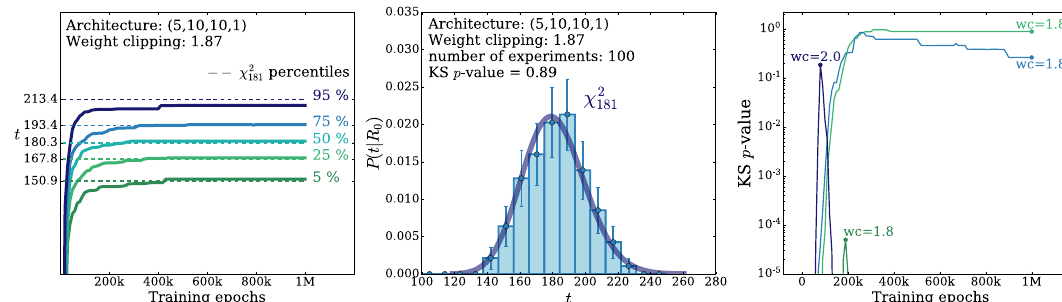
Fig. 11 Same as Fig. 9, but for the ( 5 , 10 , 10 , 1 ) architecture Table 3 Summary of the weight clipping tuning